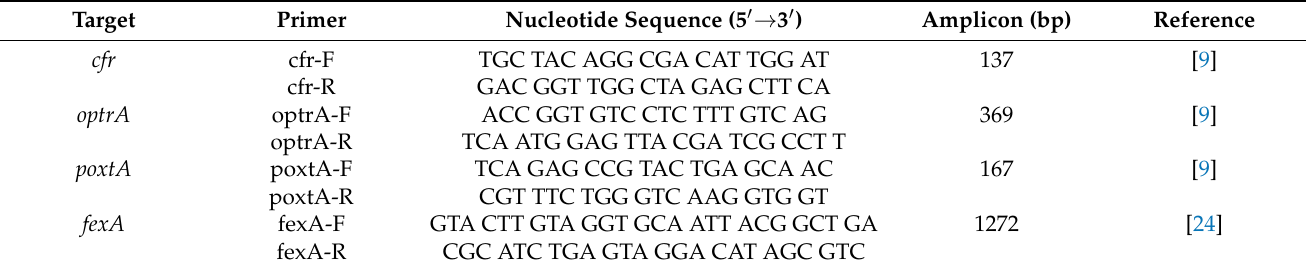
Table 6. Primer sequences for the detection of phenicol-oxazolidinone resistance